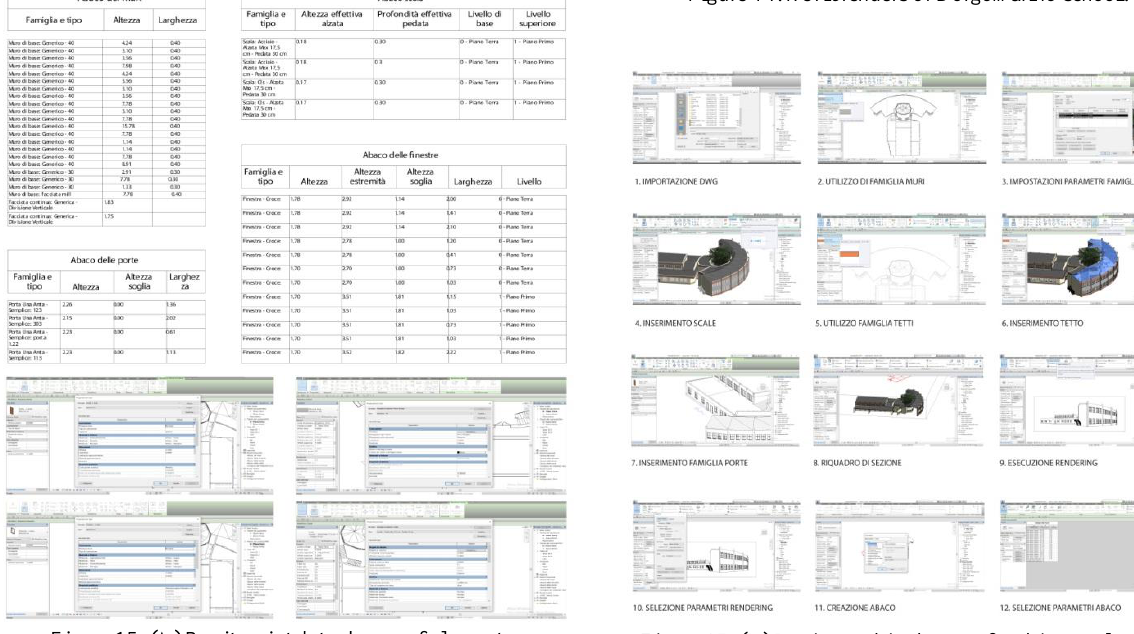
Figure 14. Revit renders of Borgomarino school.